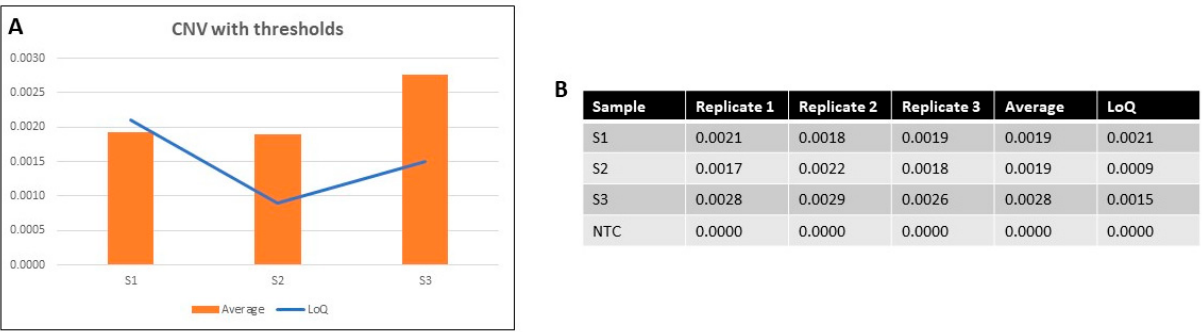
Figure 1. ( A ) Table showing the CNV calculation for each NAC and its replicates (A–E). NACs are nonamplifiable controls and should be negative for CAR Ts but positive for reference genes. The average of all 15 measurements for CAR T cell CNV was 0.001, demonstrating the level of background noise. ( B ) Graph is shown in logarithmic scale. Zero values are not shown when logarithmic scale is used. The final concentration of observed events completely followed expected values between 1 and 10 5 copies per µL, as expected by the dynamic range of the ddPCR. ( C ) A 1D plot made using the QuantaSoft software (Bio-Rad) showing sequential results of the tisagenlecleucel 4-1BB oligo at copy numbers from 0.0001 to 10 6 . NTCs were also run as negative controls alongside. The blue dots represent the tisagenlecleucel (FAM) and were seen to lose resolution as the copies of the oligo decreased, while the green dots representing albumin (HEX) (the reference gene) and had almost no events, as expected. The 10 4 dilution was chosen to be used for the next experiment of spiking, as it demonstrated here enough positive events while maintaining a good balance between positive and negative events.